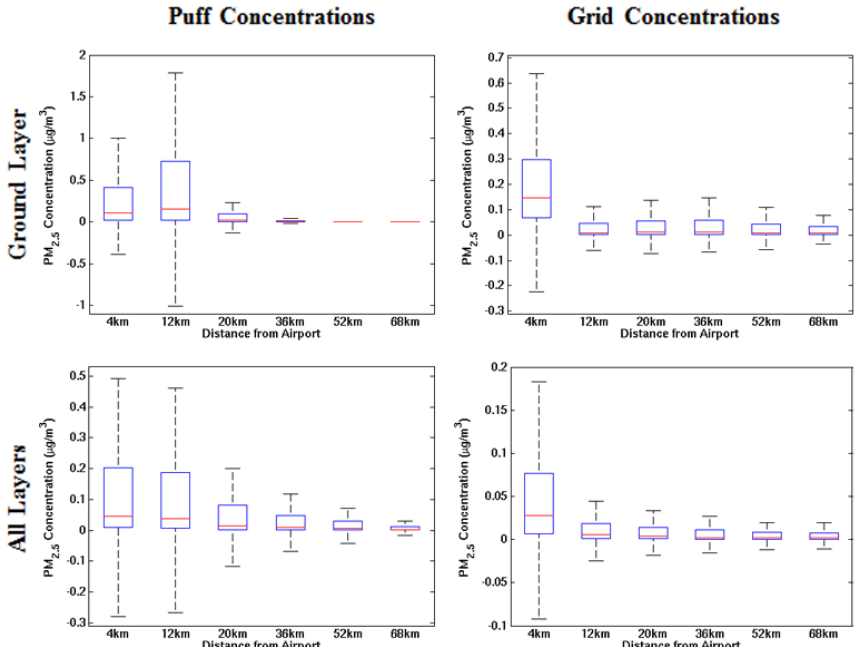
Fig. 6. Box-and-whisker plots showing the 25th, 50th (red line), and 75th percentiles, and maximum and minimum values (excluding outliers) of hourly PM 2 . 5 concentrations in puffs and in aircraft contribution to grid cells at various distances in the modeled surface layer, and in all layers. Outliers are defined as values more than 1.5 times the inter-quartile range above the 75th percentile and below the 25th percentile. All timesteps are included separately (i.e., not averaged), forming the distributions. The analysis includes only those grid cells in the outermost ring as we go outward from the airport, and thus no overlap of grid cells between each box-and-whisker. Note that the vertical axis scale varies by